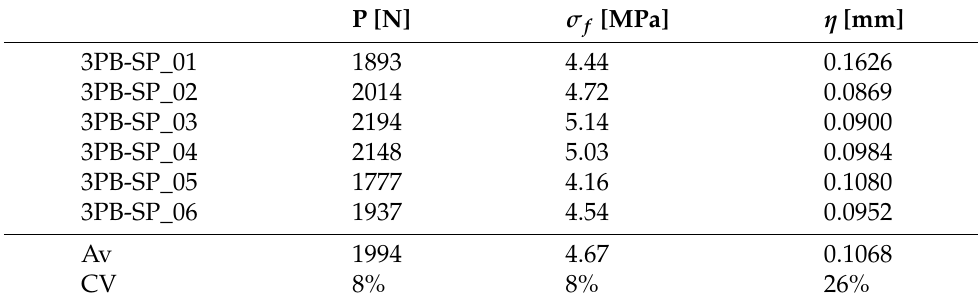
Figure 7. Load–displacement diagrams for three-point bending tests (3PB-SP). Table 4. Results of three-point bending tests (3PB-SP) in terms of maximum load P and corresponding vertical displacement η and flexural stress σ f according to the classical mono-modulus beam